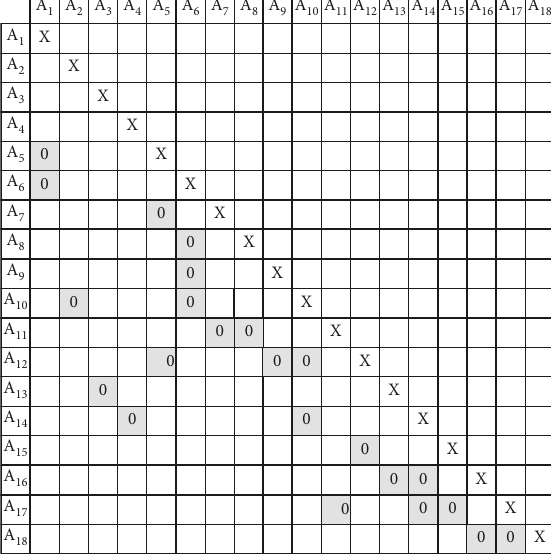
Figure 6: The OSM matrix of the